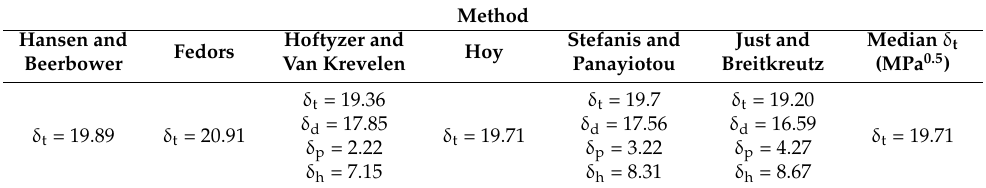
Values of solubility parameters for ibuprofen by using six different group contribution